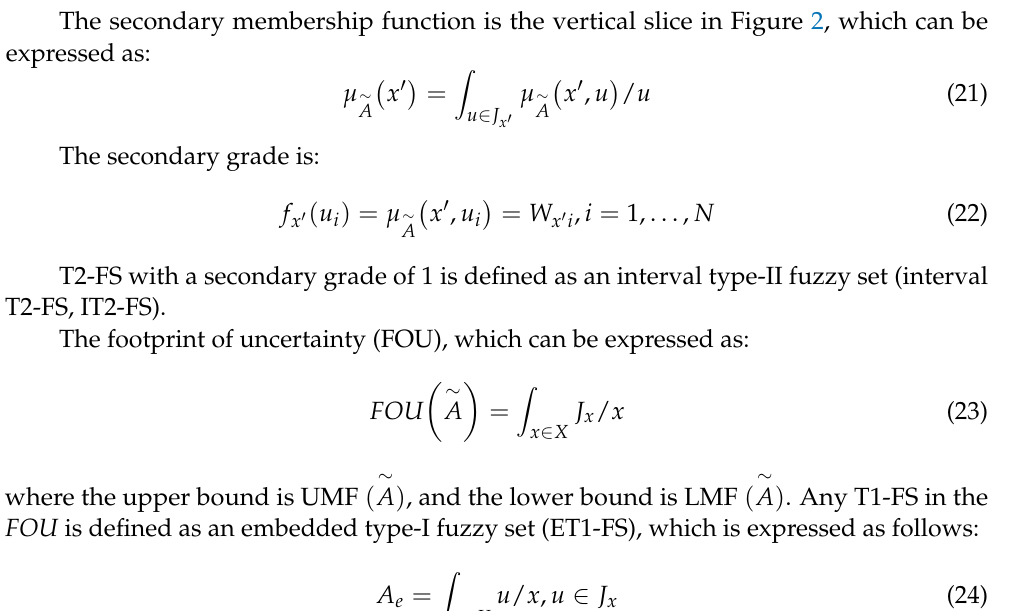
Figure 3. Block diagram describing an